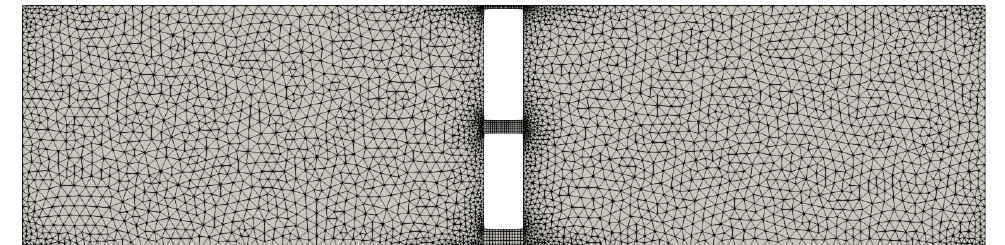
Figure 9. Full-resolution computational mesh of violent slosh test